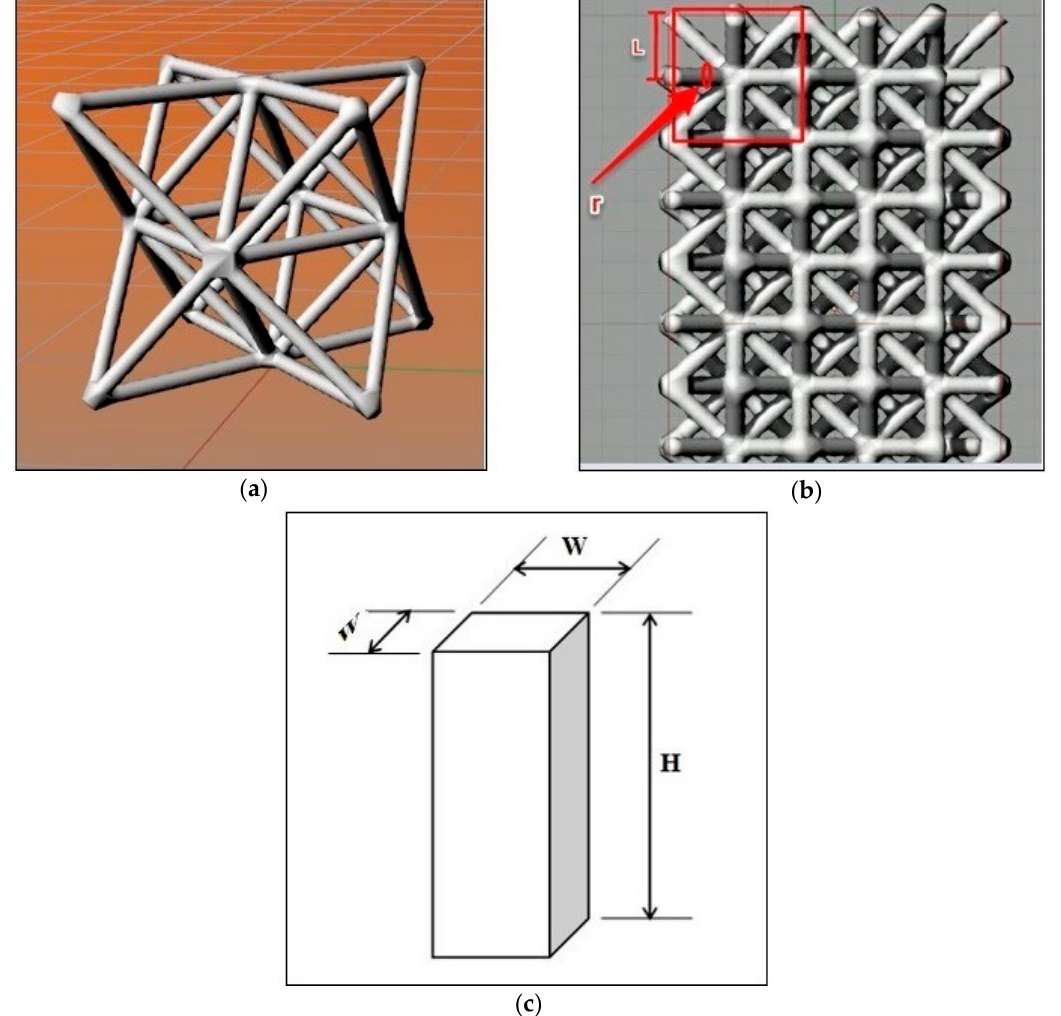
Figure 1. ( a ) Octet-truss structure generated by the Grasshopper; ( b ) Octet-truss with a toggle-true feature (which makes the outer edges of the structure unjointed); ( c ) Prismatic sample for the compression test.